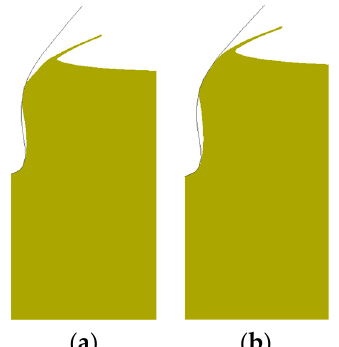
Figure 9. Comparison of the velocity of the bow section between the three loading conditions.